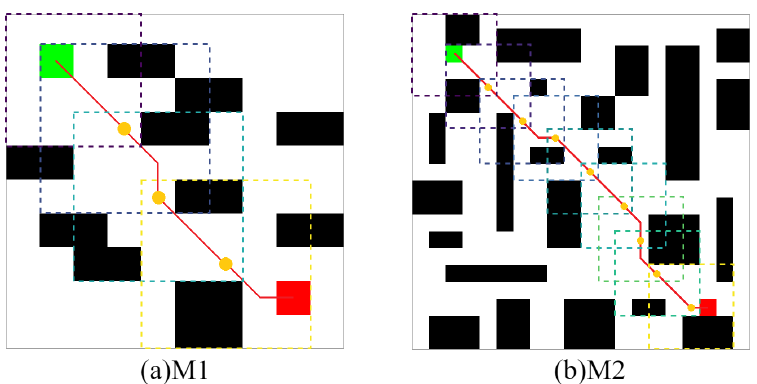
Figure 15. Local environment information of obstacle